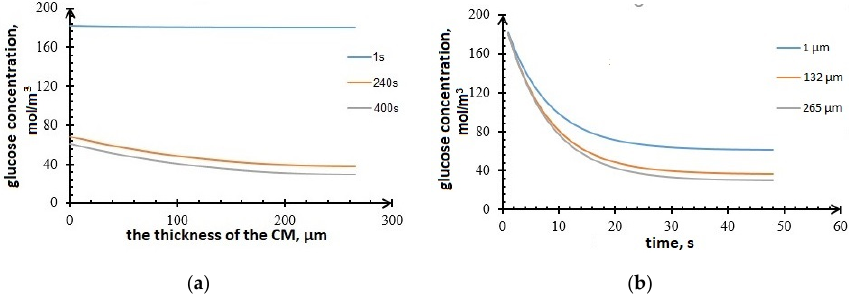
Figure 9. Glucose concentration in the anode ( a ) vs. CM thickness; ( b ) vs. time.